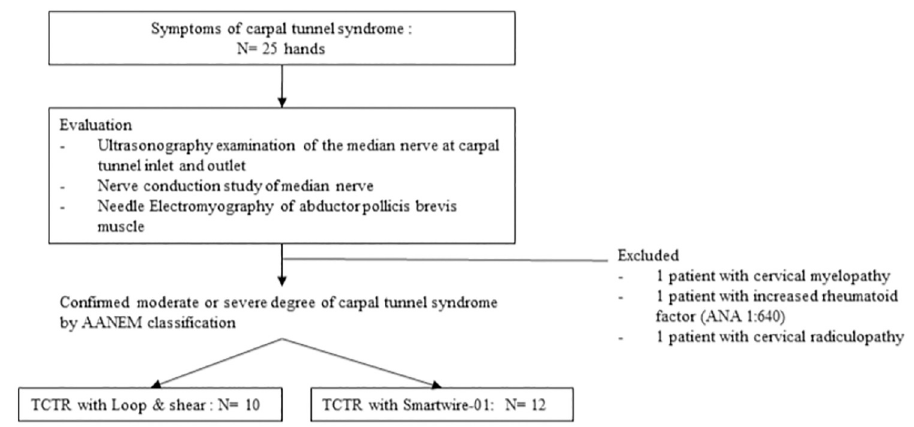
Fig 1. Flowchart detailing patient enrollment. Abbreviations: TCTR, thread carpal tunnel release.